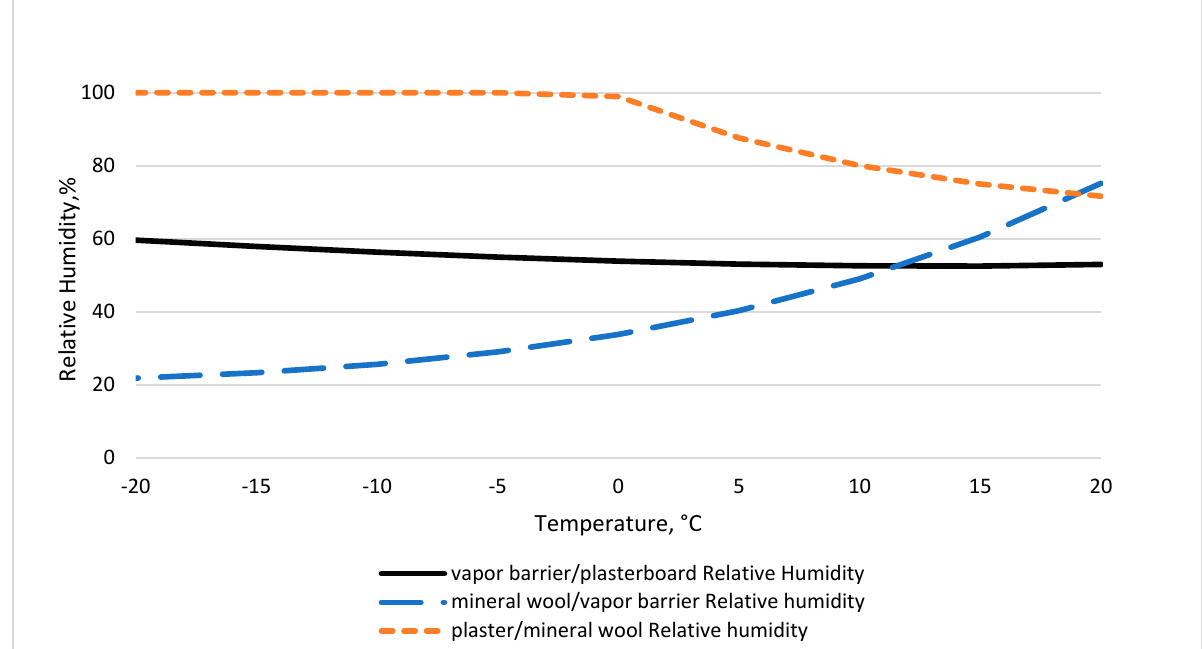
interstitial condensation in the layer between wood planks and insulation (under the insulation) when the outdoor temperature drops below − 5 °C. In the other high condensation ‐ risk planes, there is no condensation risk within the given temperature range. planes, there is no condensation risk within the given temperature range. (see Figure 11). (see Figure 11).